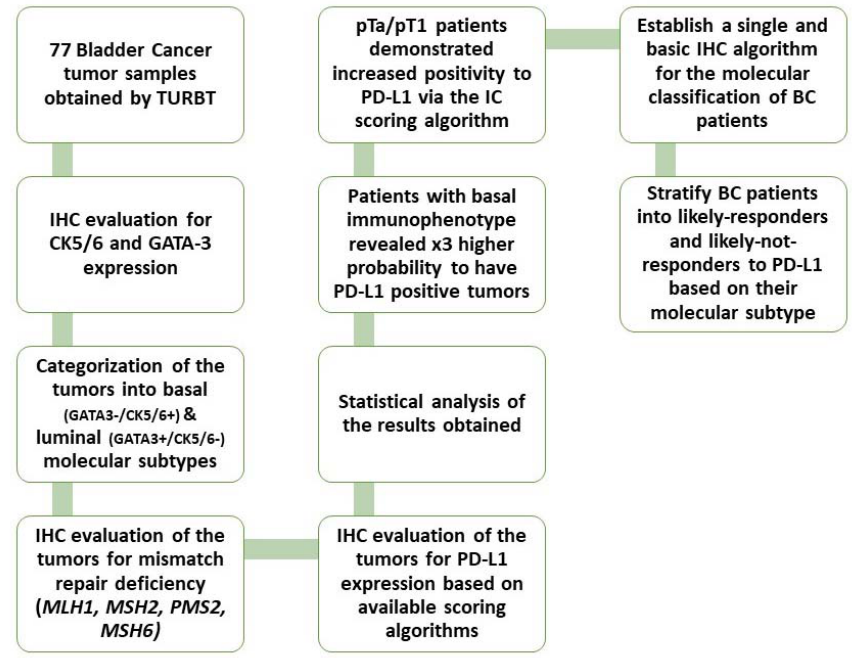
Figure 1. Workflow diagram of our study.